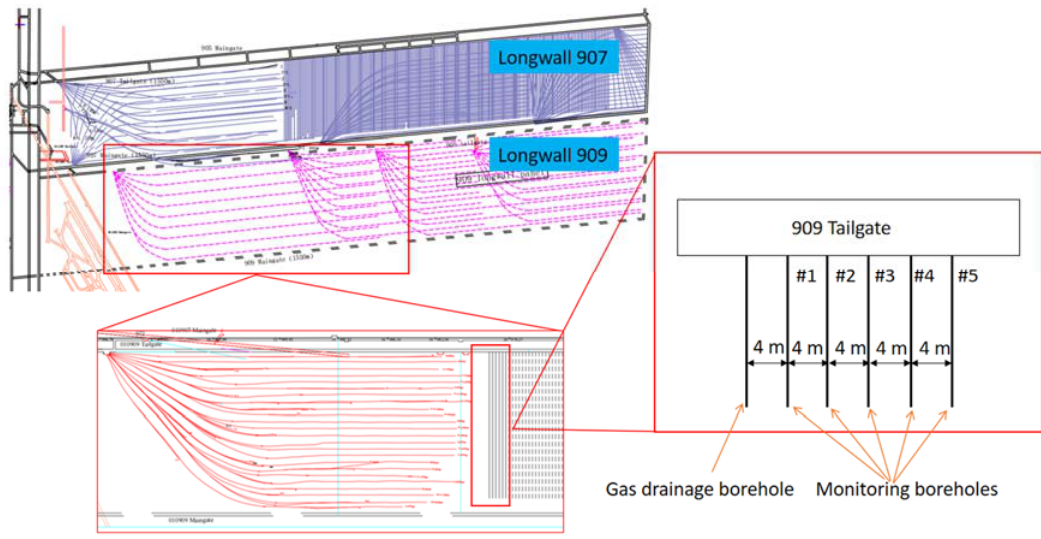
Figure 10. Gas boreholes for field observations.